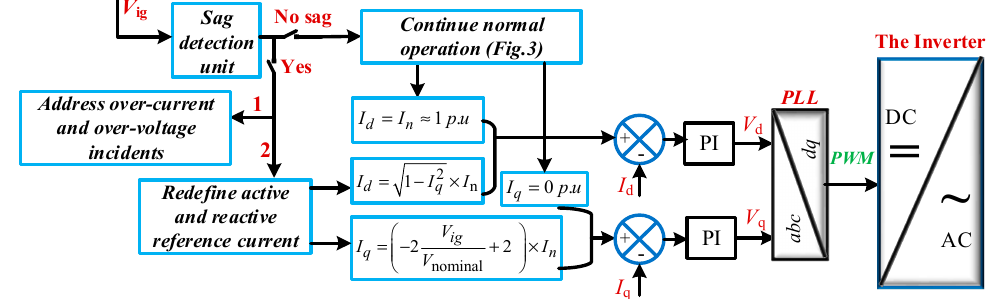
Figure 6. Schematic diagram of the proposed LVRT control strategy for sag mitigation.